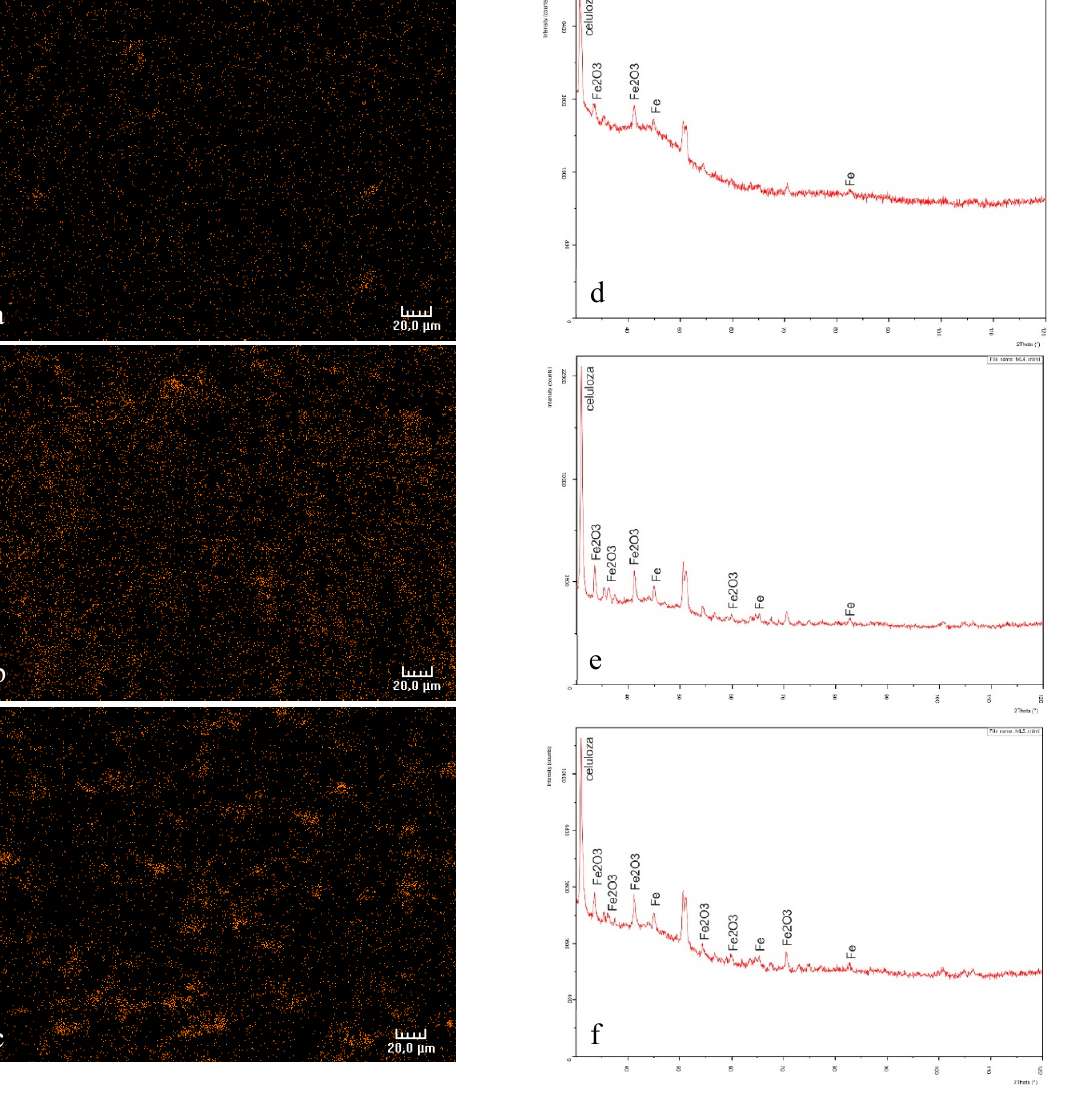
Figure 1. EDS maps of Fe identification on ZVI/PLA films with the addition of 1% ( a ), 3% ( b ), or 5% ( c ) of ZVI, respectively. XRD spectra for ZVI/PLA films with the addition of 1% ( d ), 3% ( e ), or 5% ( f ) of ZVI, respectively.